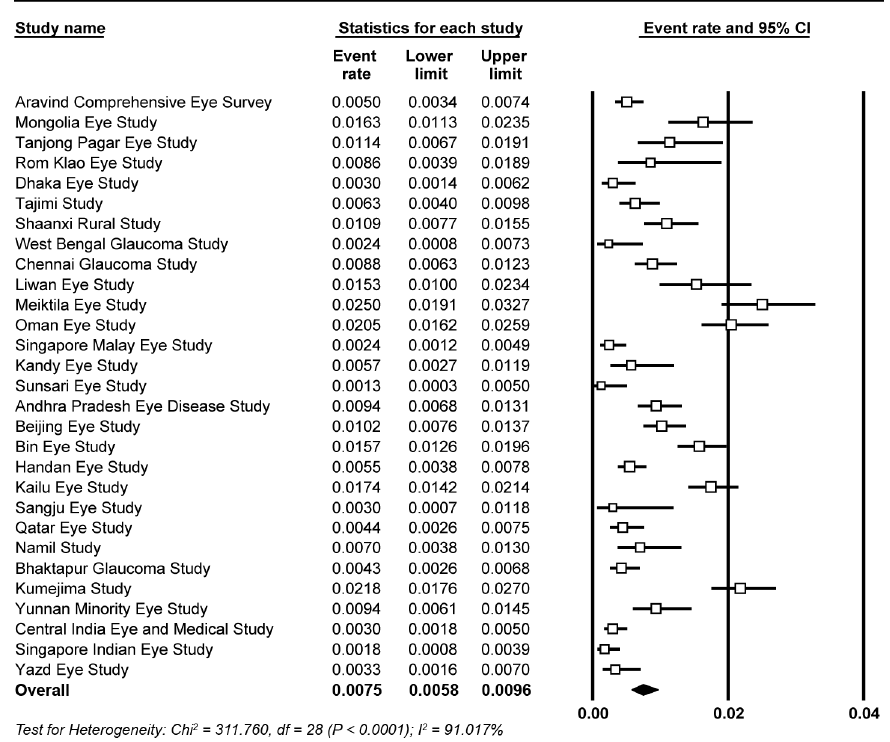
Figure 2. The forest plot of the prevalence of primary angle closure glaucoma.